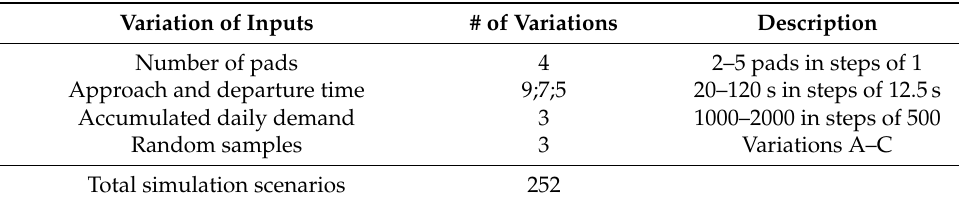
Table 3. Study design for pad-related drivers of operations.